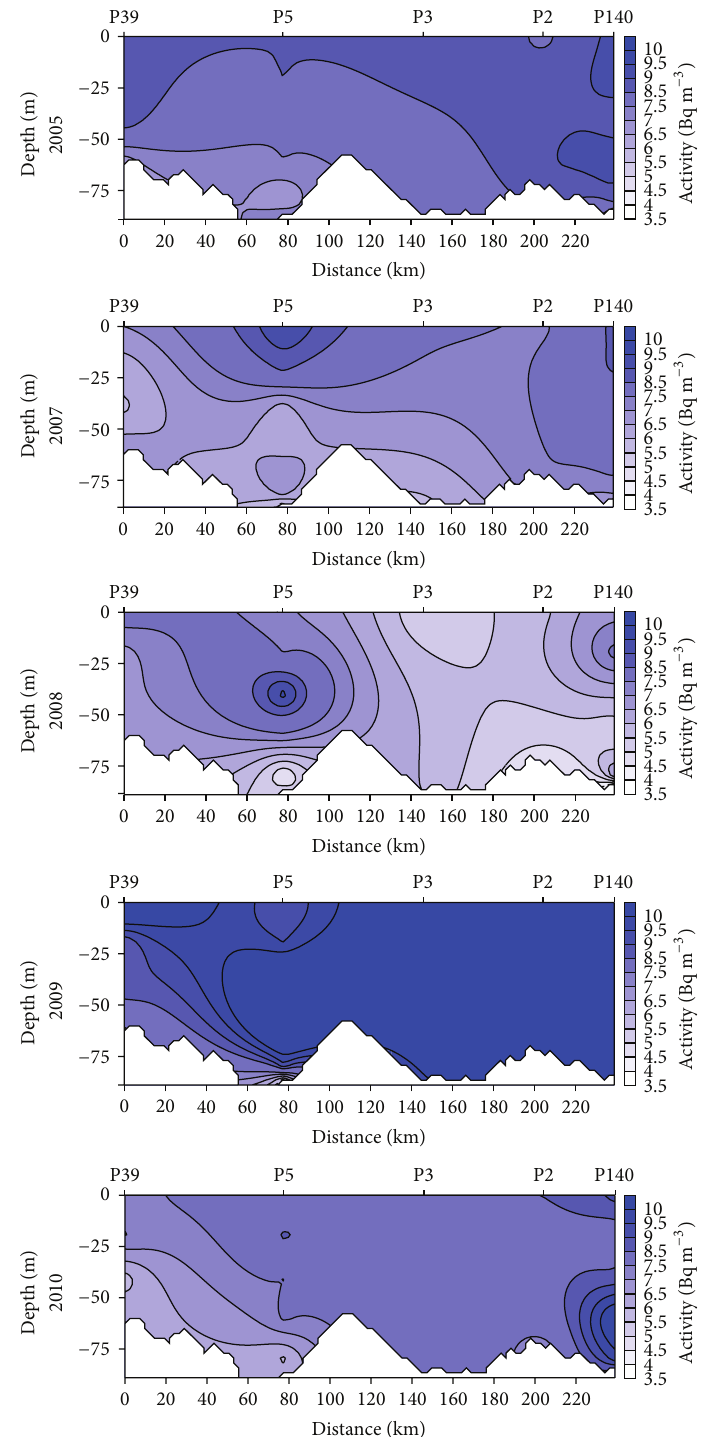
Figure 4: Seasonal and spatial variations in 90 Sr activity in the offshore profile in the years of 2005–2010.